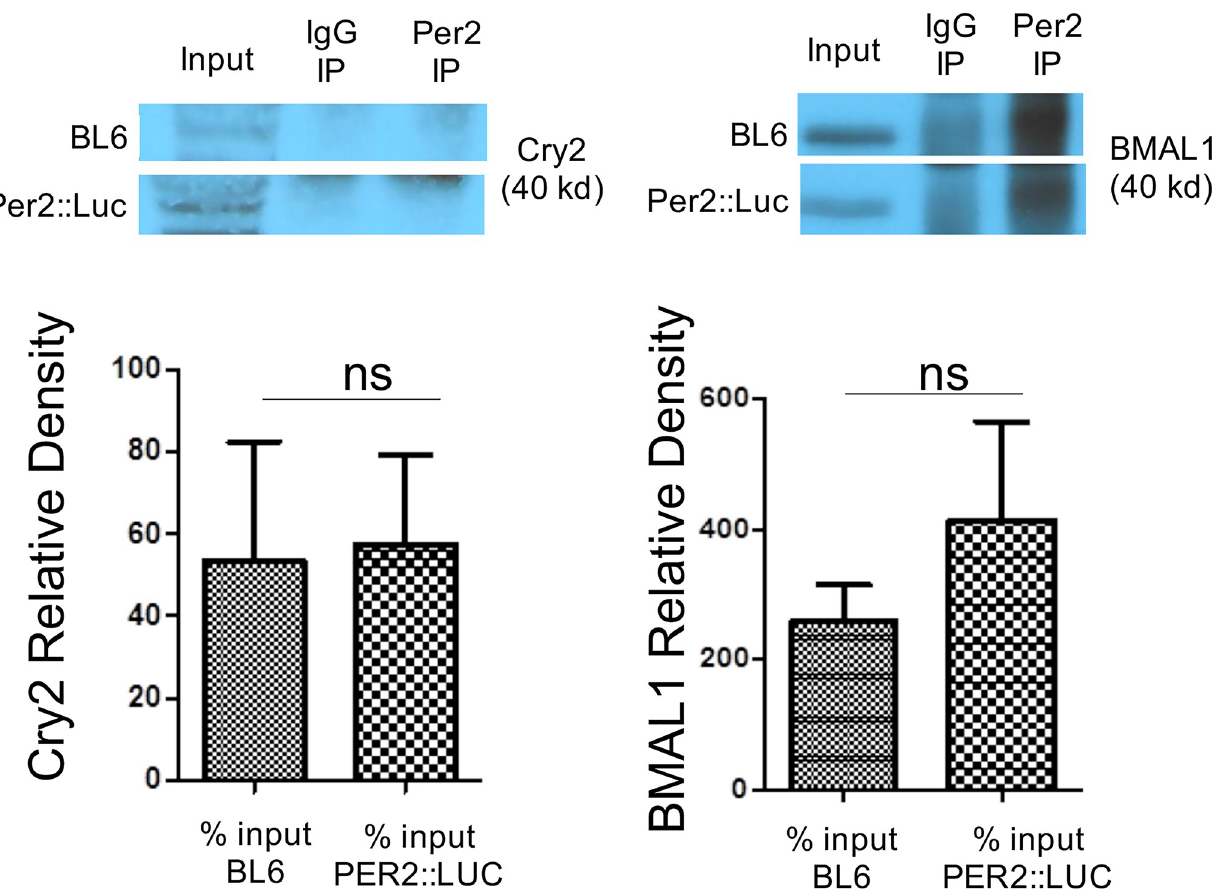
Fig 1. Colon tissue Per2::Luc mice Per2 protein displays typical interaction with Cry2 and Bmal1 circadian proteins. We compared interactions of Per2::Luc fusion protein vs. WTBL6 Per2 protein with well validated circadian protein binding partners for Per2, namely Cry2 and Bmal1 proteins using immunoprecipitation with Per2 Ab of colon tissue lysates. Data for Cry2 (left) and Bmal1 (right) show no significant difference in binding of either Cry2 or Bmal1 with the Per2::Luc protein vs. the normal BG proteins. The relative density of Cry2 and Bmal1 are represented for BL6 and Per2::Luc mice. There was no difference in colon tissue levels of Cry2 or Bmal1 levels at a single time point (p = 1.0 and 0.7, respectively). Blots are representative of n = 4 mice.